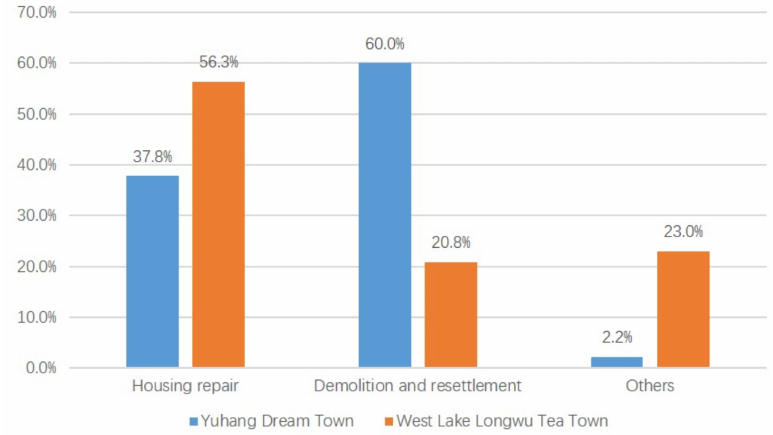
Figure 16. Reasons why respondents’ family housing environment has improved due to the CT practice (source: authors).